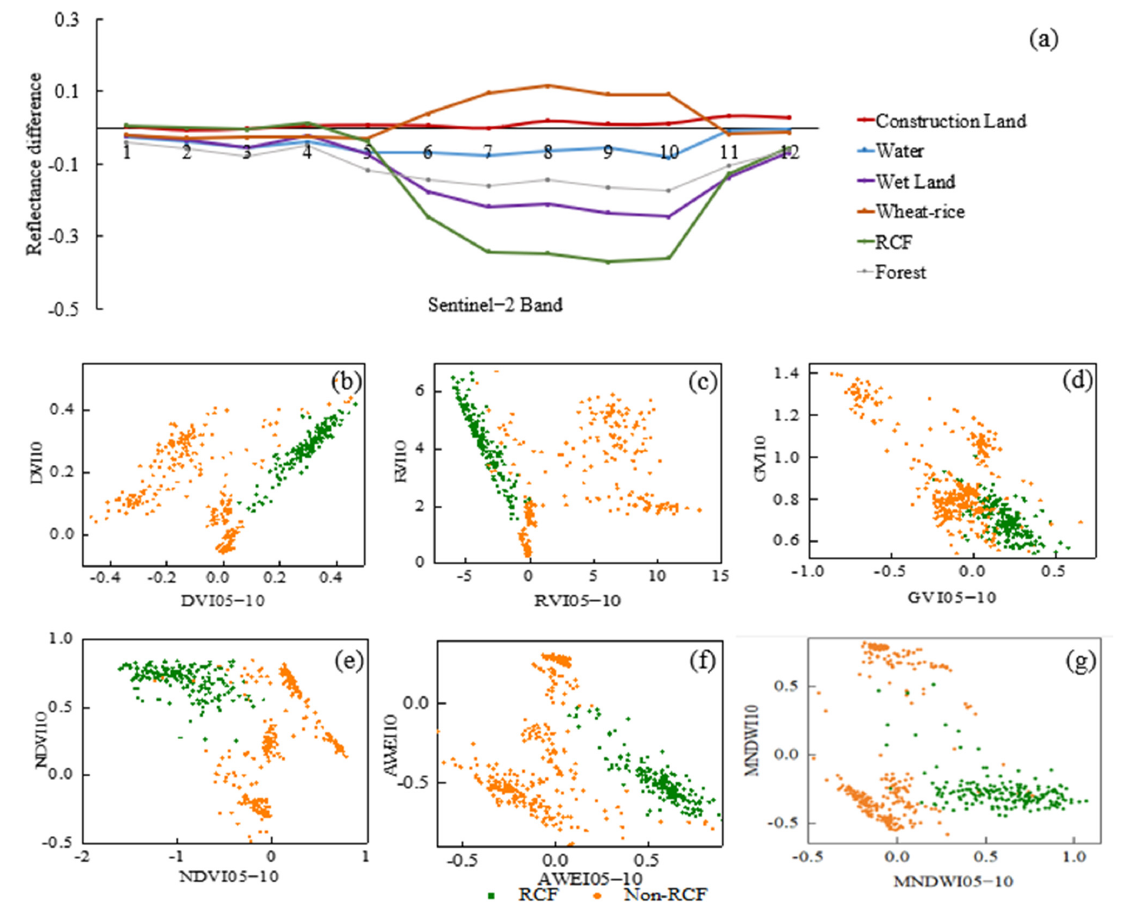
Figure 6. ( a ) The difference in spectral reflectance between the RCFs and non-RCFs during the two